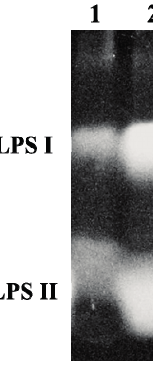
Figure 2. SDS-PAGE of LPS from wild-type, waaL knock-out mutant, and complemented strains. LPS I is the high molecular weight form of the LPS, which contains the O -antigen. LPS II lacks the O -antigen. Lane 1, LPS standard from E. coli serotype 055:B5 (Invitrogen, Carlsbad, CA, USA); Lane 2, 61A101C; Lane 3, JS015; Lane 4,